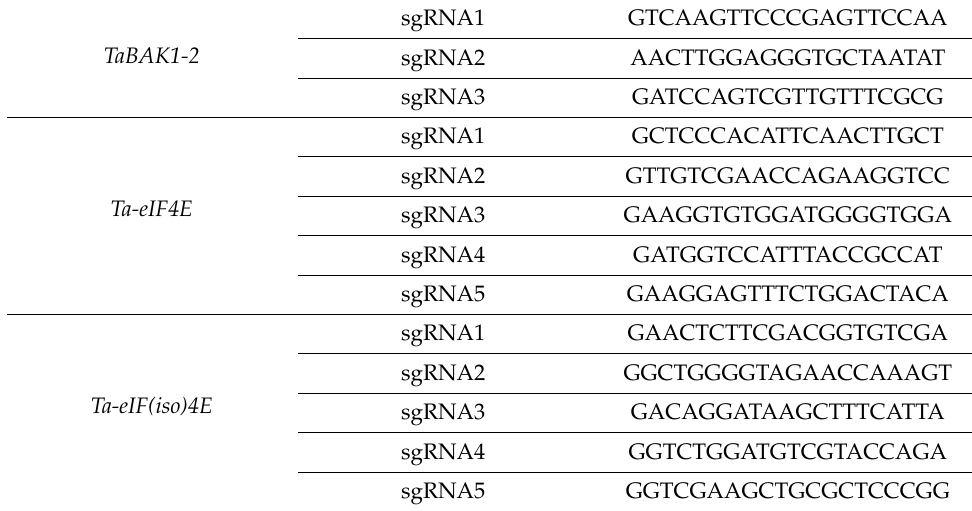
Table 1. CRISPR/Cas